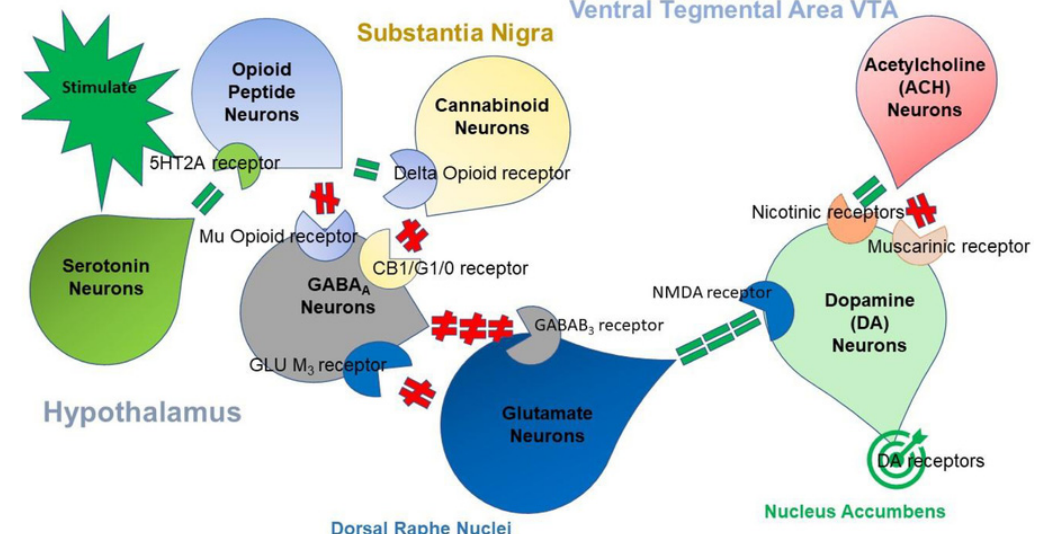
Figure 1. The Brain Reward Cascade : In the hypothalamus, environmental stimulation results in the release of serotonin, which in turn via, for example, 5HT-2a receptors activate (green equal sign) the subsequent release of opioid peptides from opioid peptide neurons the hypothalamus. In turn, the opioid peptides have two distinct effects, possibly via two different opioid receptors. One inhibits (red hash sign) through the mu-opioid receptor (possibly via enkephalin) and projects to the substantia nigra to GABAA neurons. Another stimulates (green equal sign) cannabinoid neurons (for example, the anandamide and 2-archydonoglcerol) through beta–endorphin-linked delta receptors, which in turn inhibit GABAA neurons at the substantia nigra. When activated, cannabinoids, primarily 2-archydonoglcerol, can indirectly disinhibit (red hash sign) GABAA neurons by activating G1/0 coupled to CB1 receptors in the Substantia Nigra. In the dorsal raphe nuclei (DRN), glutamate neurons can then indirectly disinhibit GABAA neurons in the substantia nigra through activation of GLU M3 receptors (red hash sign). GABAA neurons, when stimulated, will, in turn, powerfully (red hash signs) inhibit VTA glutaminergic drive via GABAB 3 neurons. Stimulation of ACH neurons at the nucleus accumbens ACH can possibly stimulate both muscarinic (red hash) or nicotinic (green hash). Finally, glutamate neurons in the VTA will project to dopamine neurons through NMDA receptors (green equal sign) to preferentially release dopamine at the nucleus accumbens (NAc), shown as a bullseye, which indicates a euphoria, or “wanting” response [86].